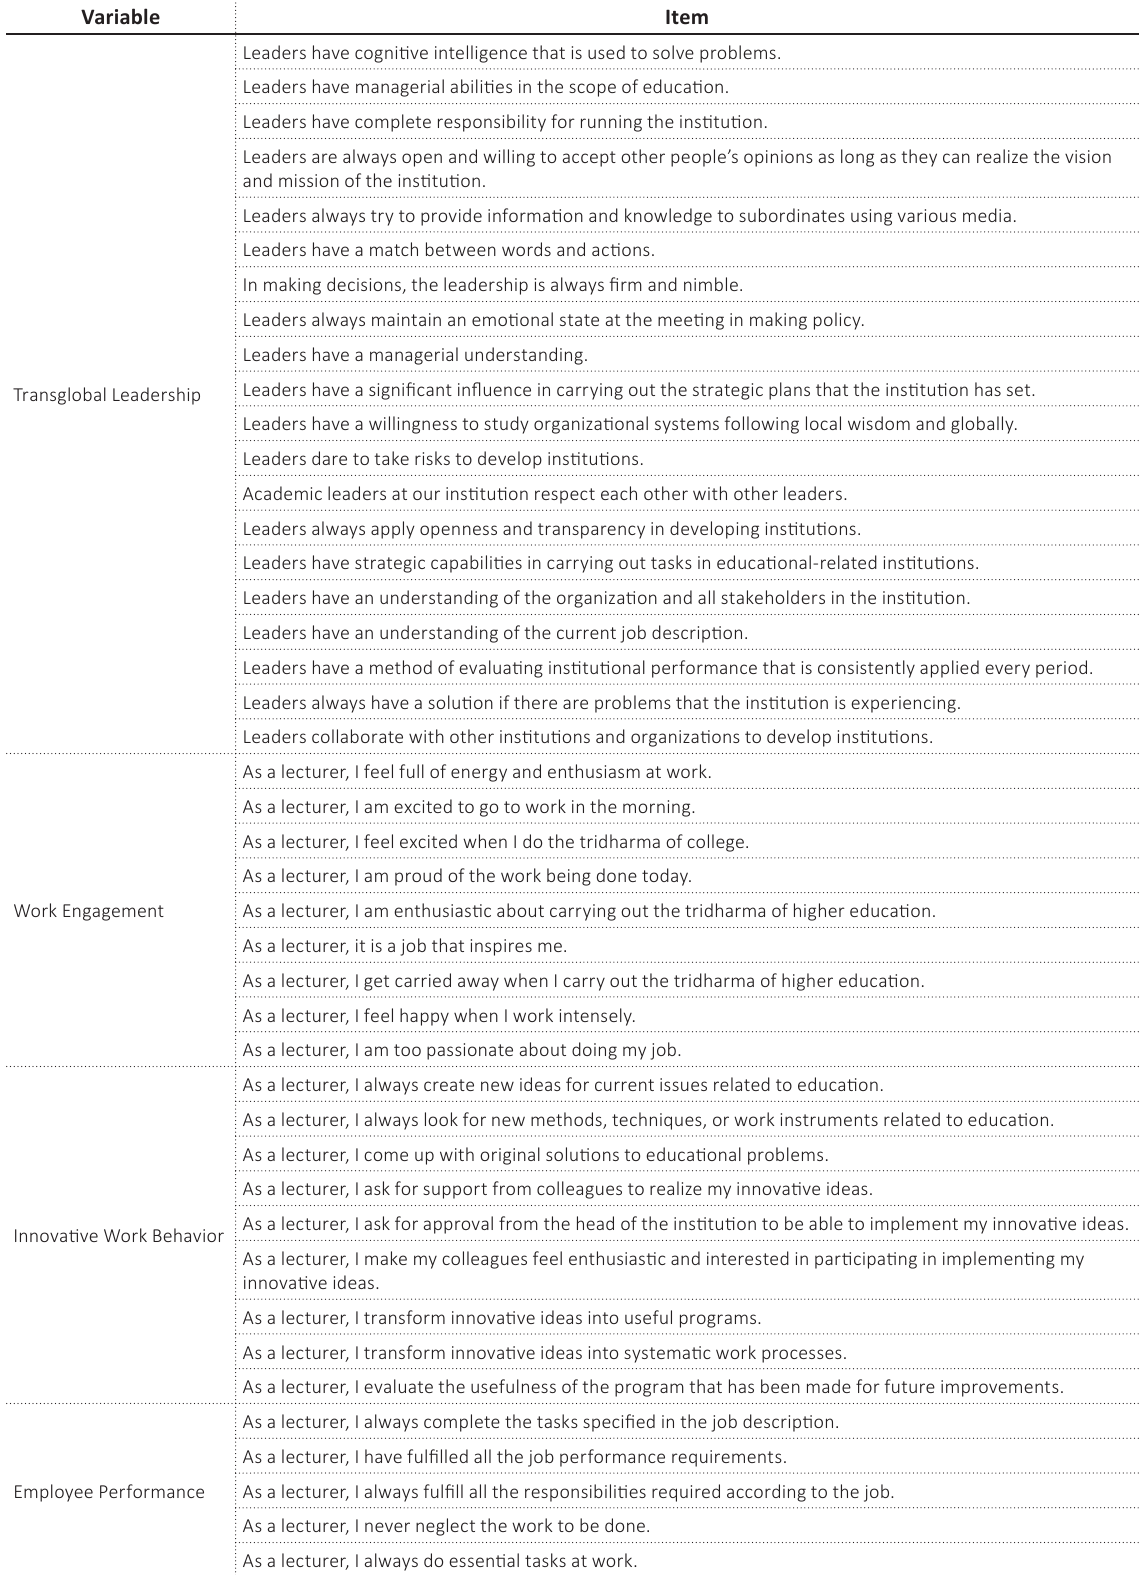
Table A1. Definitions of variables Variable Item